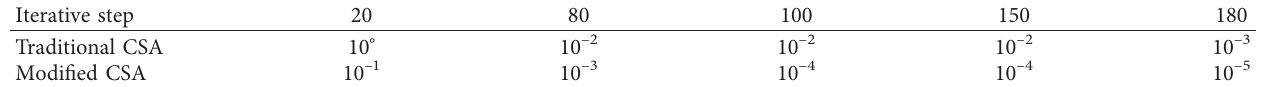
Table 10: Comparison of computation residuals by different methods.